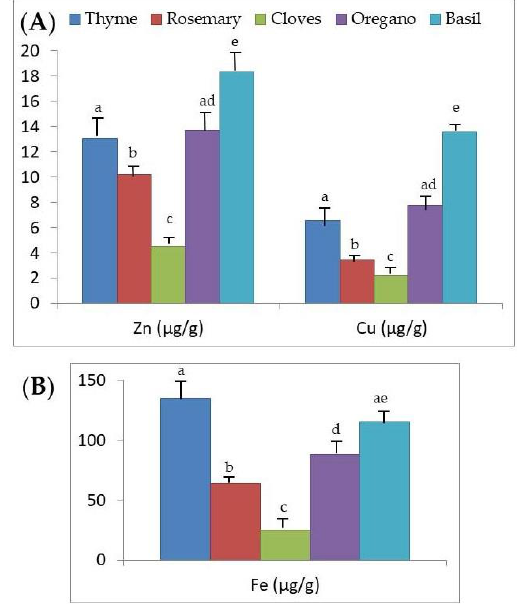
Figure 1. Mean ( A ) Zn, Cu, and ( B ) Fe concentrations (μg/g) measured in dehydrated aromatic herbs (thyme, rosemary, cloves, oregano, and basil). Mean Zn, Cu, and Fe values; different superscripts indicate significant differences between the aromatic herbs ( p < 0.001).